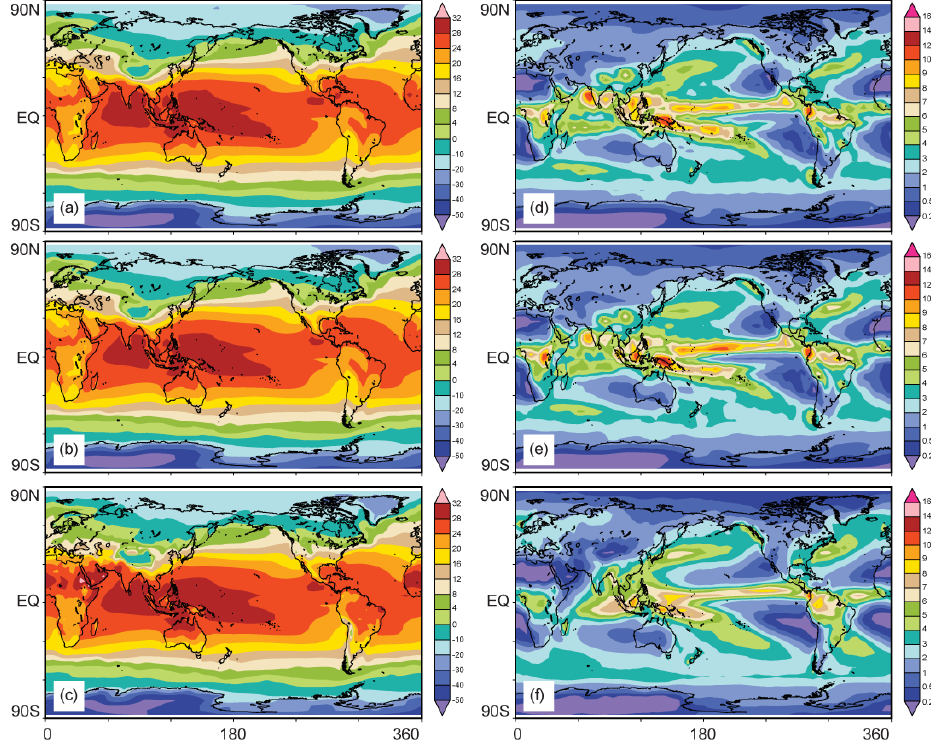
Fig. 5. Global annual SAT (left column, ◦ C) and precipitation (right column, mm d − 1 ) simulated in the pre-industrial (a, d), and the control (b, e) experiment, with comparison to the ERA-interim 1979–2008 SAT (c) and GPCP 1979–2008 precipitation (f)